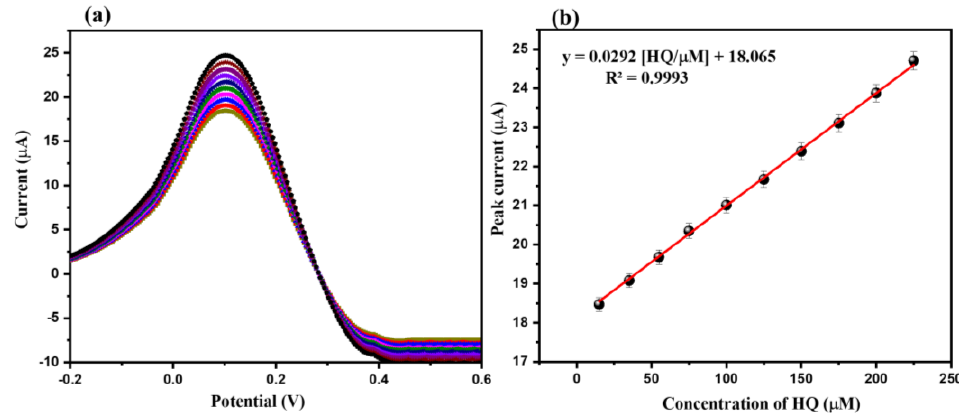
Figure 8. DPVs ( a ) of CeO 2 /GCE in presence of HQ (15, 35, 55, 75, 100, 125, 150, 175, 200, and 225 µM) in 0.1 M PBS (pH = 7.0) (applied scan rate = 50 mV/s). Calibration curve of peak current versus concentration ( b ).